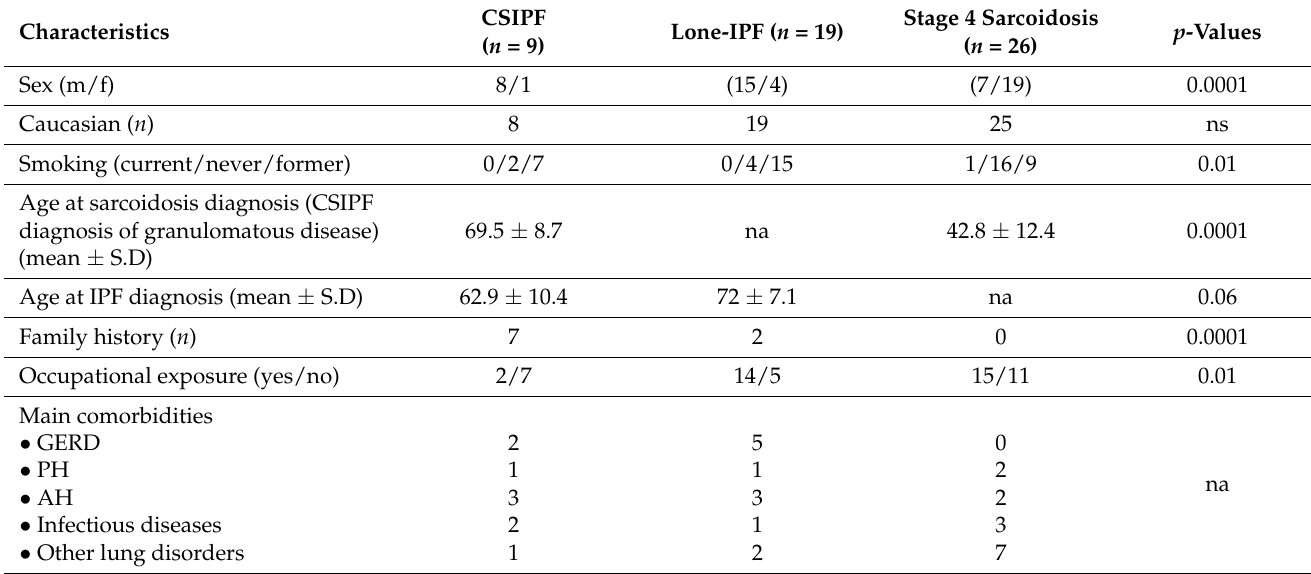
Table 2. Demographic, historical and imaging characteristics of IPF, CSIPF and lone-IPF